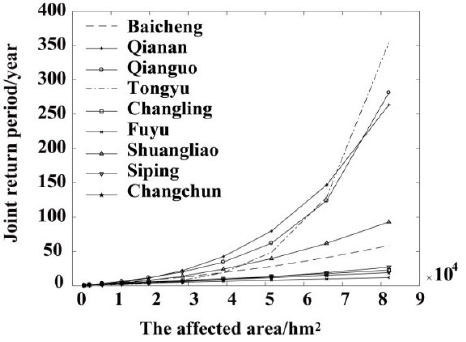
Figure 7. Flood risk curves for crops in the MJP.